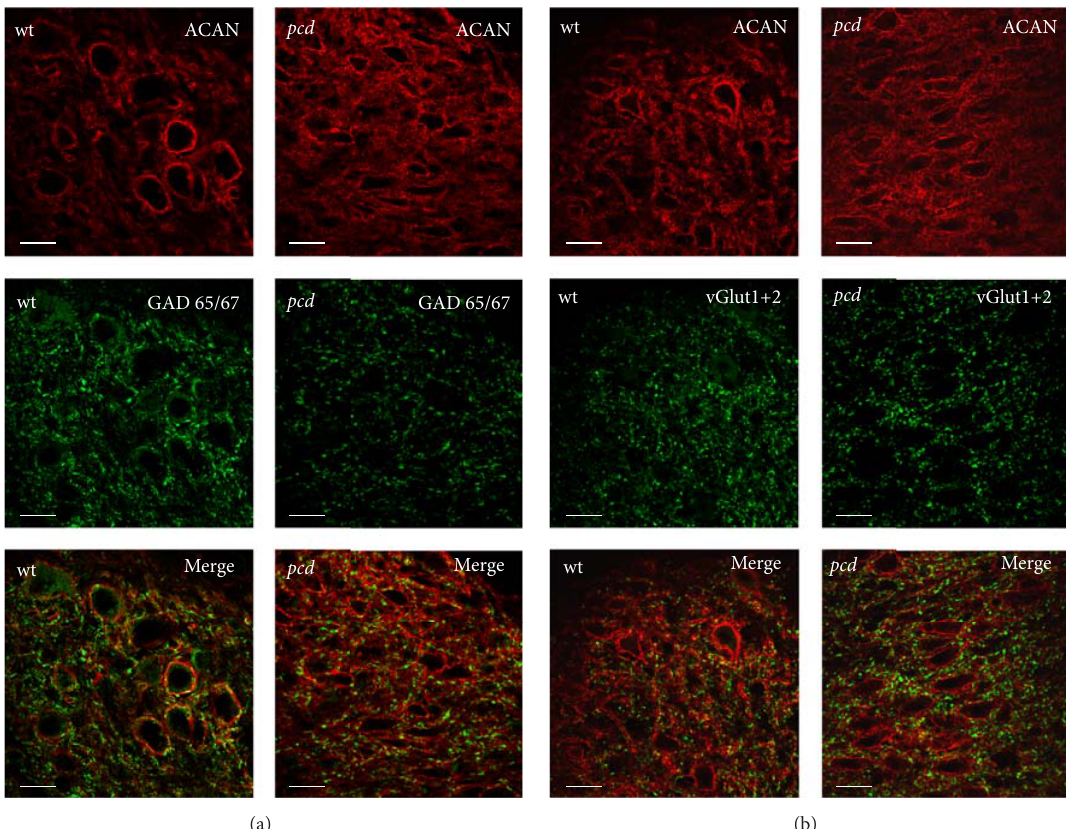
Figure 2: Detection of glutamatergic and GABAergic terminals in DCN. The large DCN neurons are enwrapped by aggrecan-based ECM (red). (a) DCN neurons are innervated by GABAergic boutons, labeled by GAD 65/67. GABAergic terminals seem to be reduced in pcd . (b) The glutamatergic boutons at DCN neurons are discovered by moderate vGlut 1 and vGlut 2 staining. The staining in pcd appears slightly enhanced. Scale bar: 20 𝜇